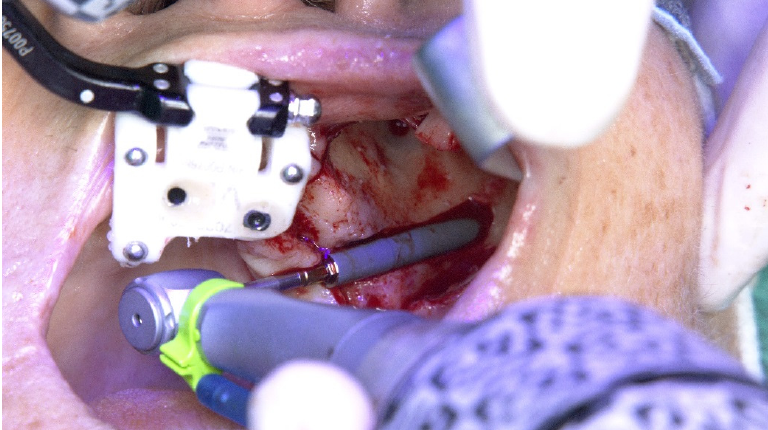
Figure 28. Perioperative photograph during the zygomatic implant insertion.